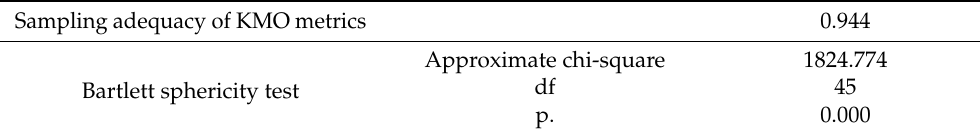
Table 10. KMO and Bartlett Tests of Employee Work Performance.